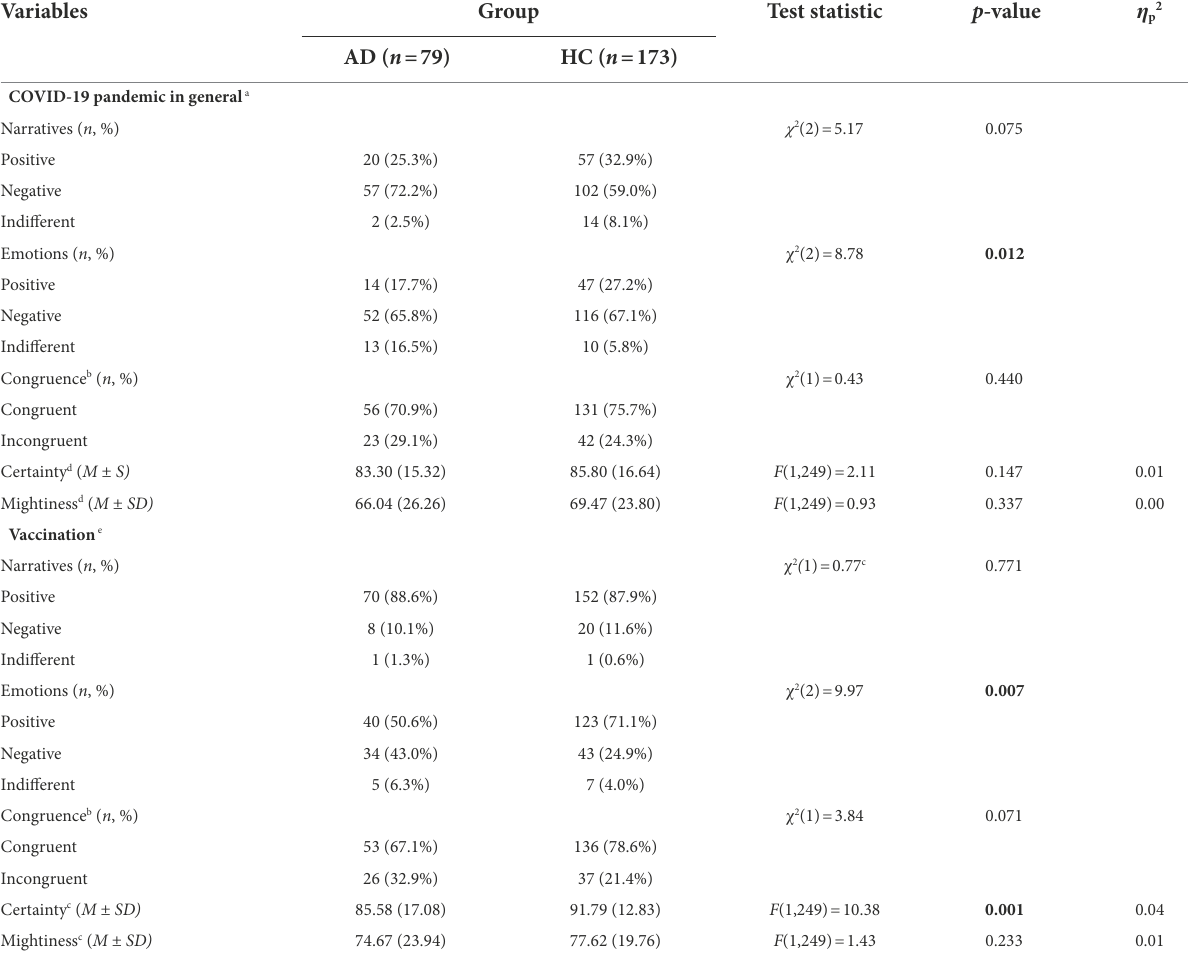
TABLE 3 Descriptive statistics of the believing parameters of individuals with affective disorders and healthy